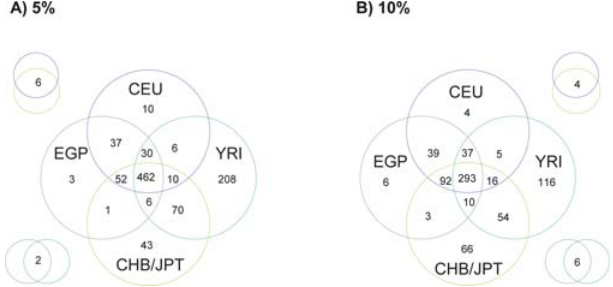
Figure 4. Four-Way Comparison of Common